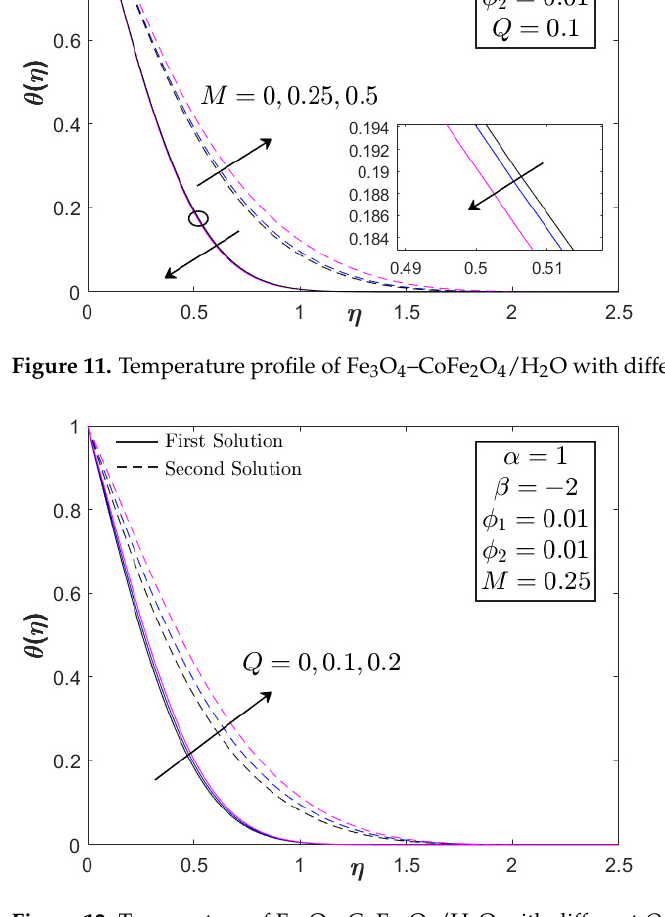
Figure 12. Temperature of Fe 3 O 4 –CoFe 2 O 4 /H 2 O with different Q . Table 3. Validation of f (cid:48)(cid:48) ( 0 ) when φ 1 = φ 2 = Q = 0, β = − 1, and α = 1, with various M